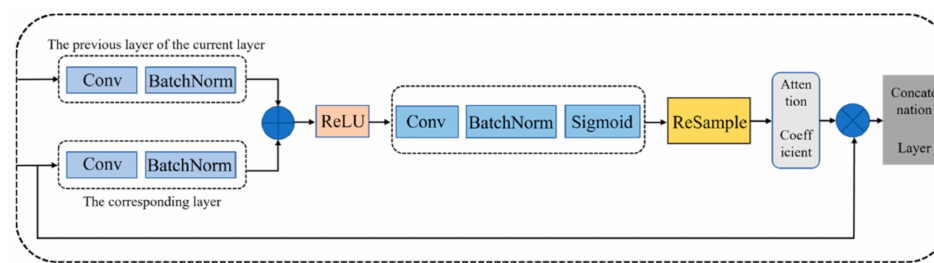
Figure 2. The architecture of the AUOSD model.